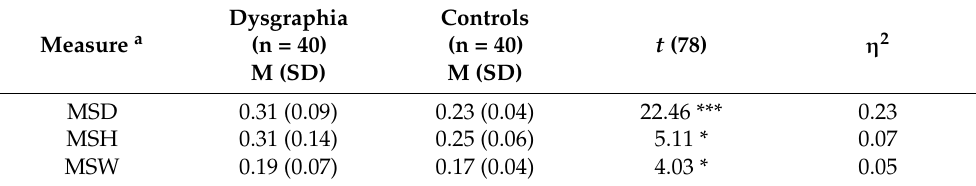
Table 3. Comparison between groups for handwriting performance measures.